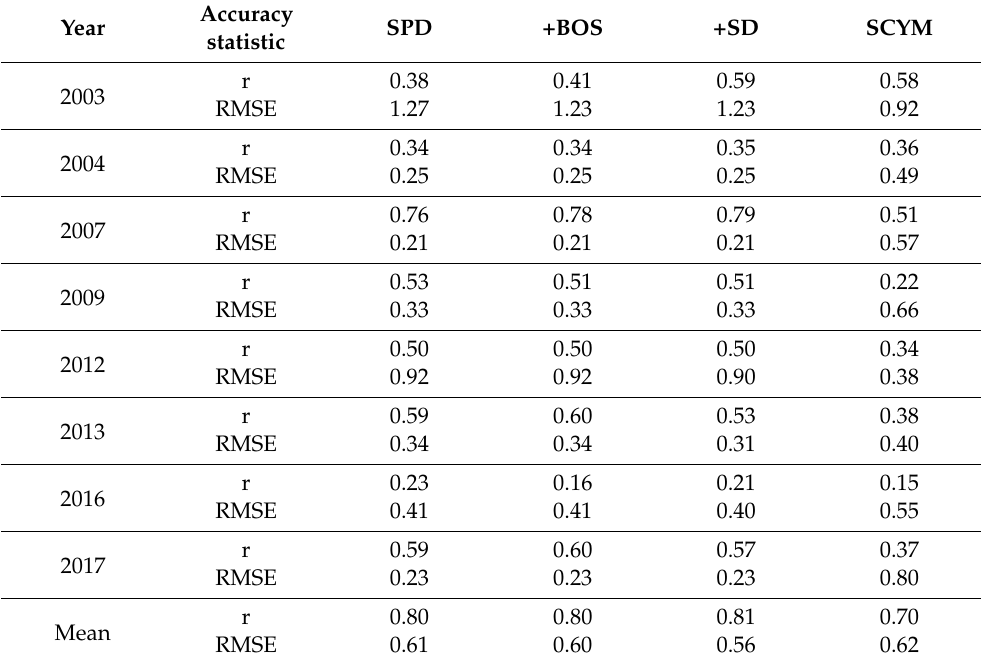
Table 5. Annual accuracy statistics comparing actual yield and estimated yields using the four models: Statistical phenology detection (SPD), statistical phenology detection incorporates sowing date (+SD), statistical phenology detection incorporates break of season (+BOS) and scalable crop yield mapper (SCYM). Accuracy statistics reported are correlation coefficient (r) and root mean square error (RMSE). Accuracy SPD +BOS +SD SCYM Year statistic 2003